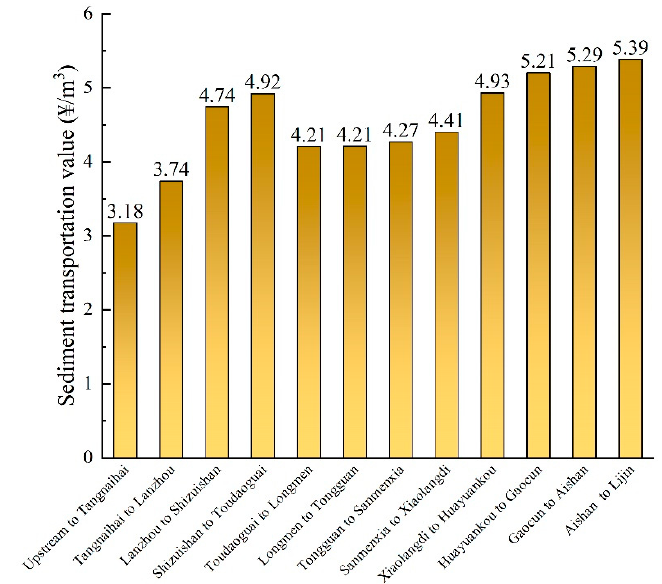
Figure 2. Analysis of sediment transport values of sections of the Yellow River Basin.